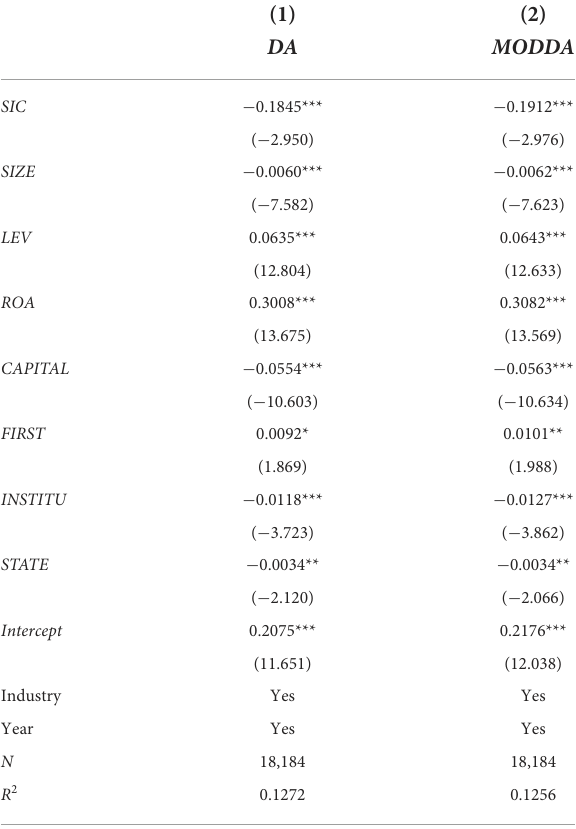
TABLE 3 Social insurance contributions and earnings